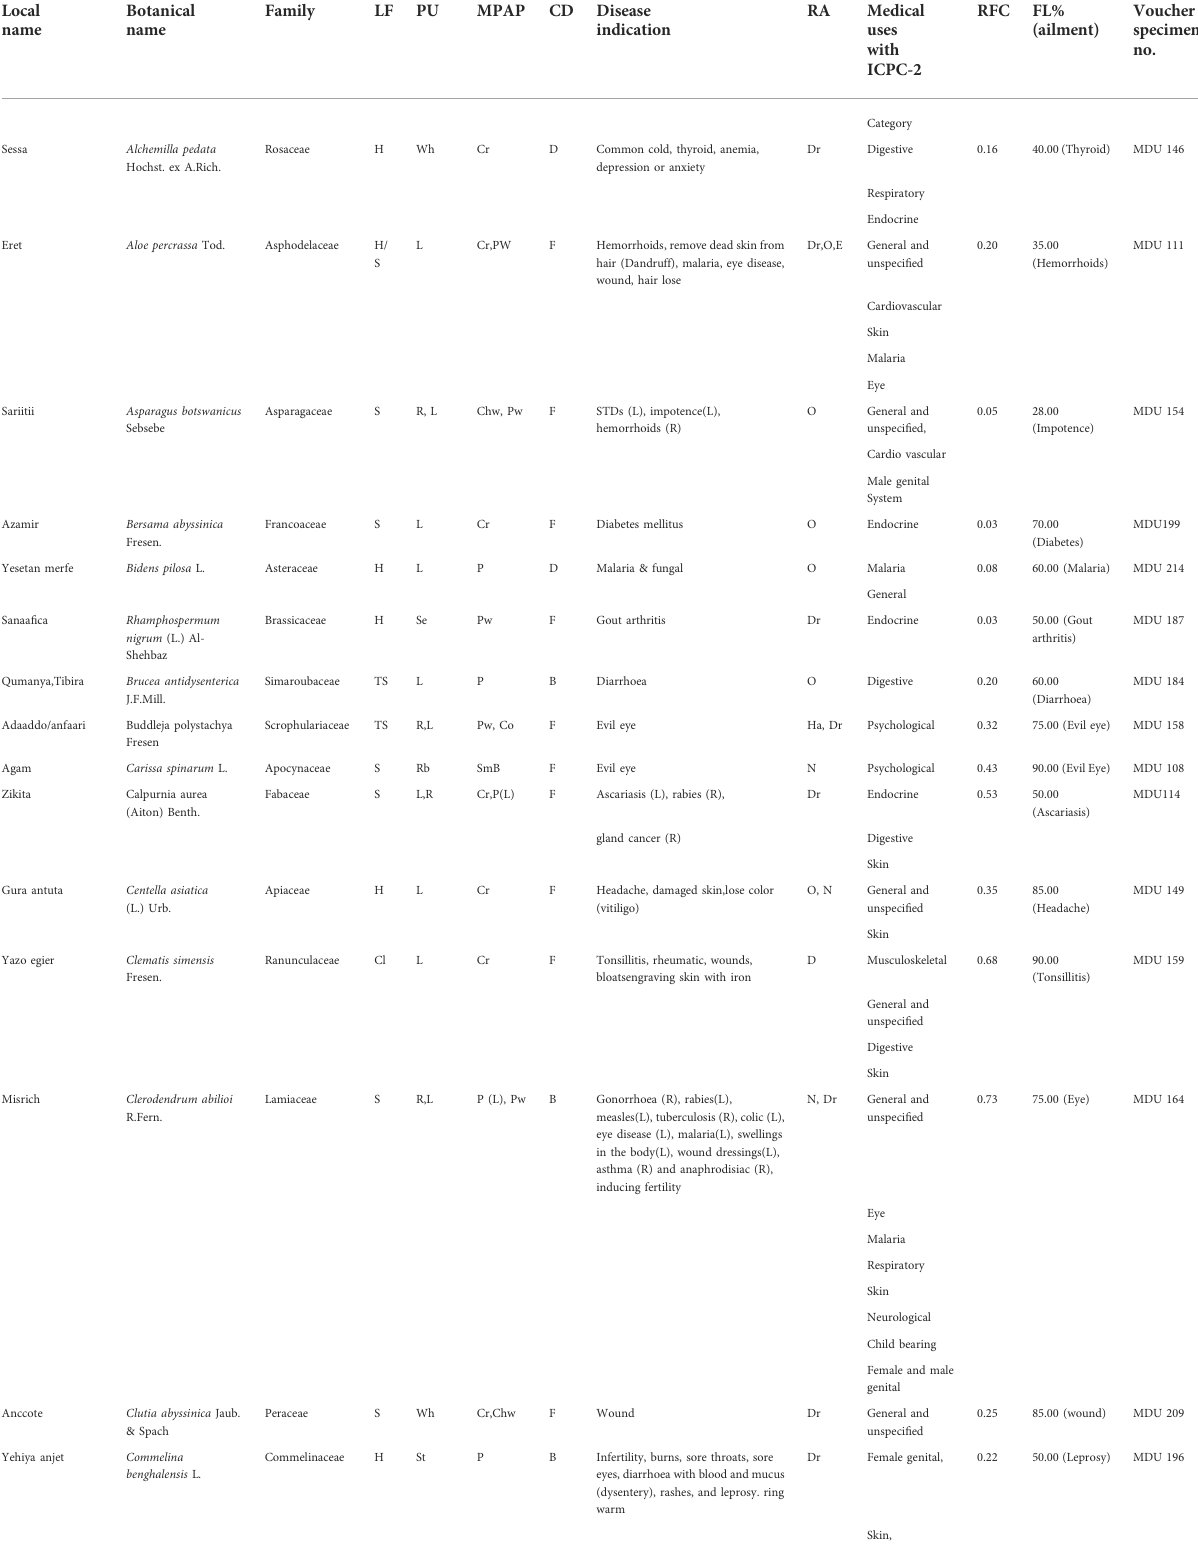
TABLE 2 Ethnobotanical information of medicinal plants used by traditional healers in Gullele botanical garden in treating human